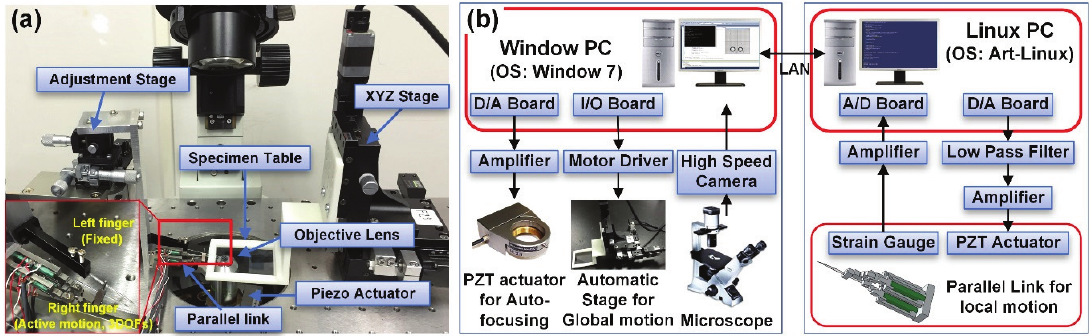
Figure 1. System of microhand. ( a ) Overall system of microhand; ( b ) System